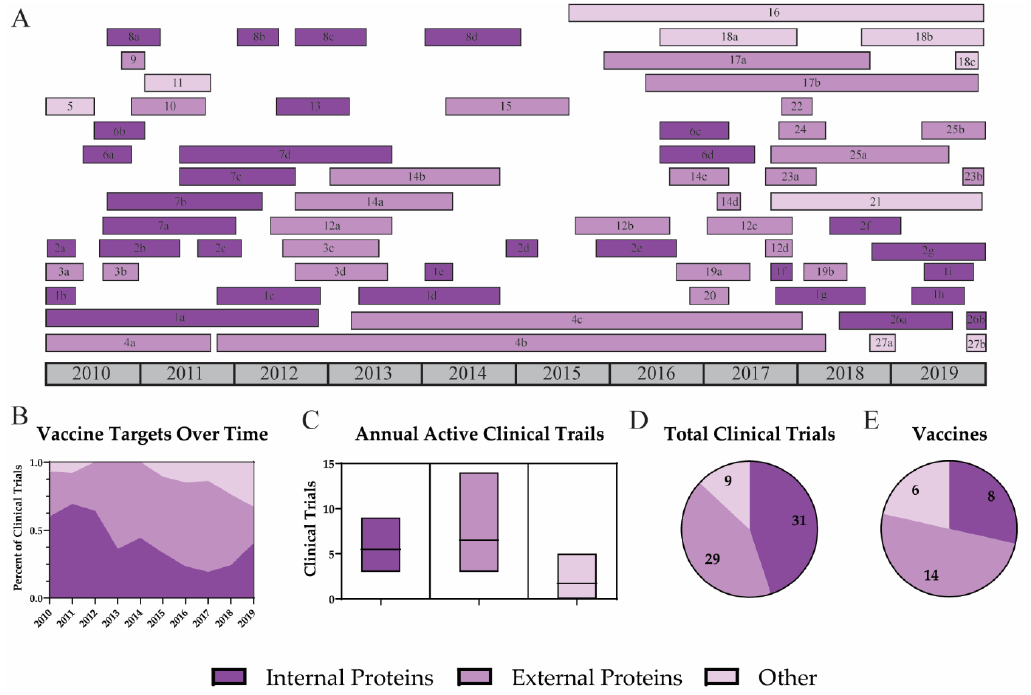
Figure 2. Targets for universal influenza vaccine strategies. A timeline of all universal influenza vaccine clinical trials is shown for vaccines which target internal proteins (dark purple), external proteins (purple), or other (light purple) antigens ( A ). Trends for vaccine targets are shown by the percent of active clinical trials each year ( B ). Average clinical trials for each target ( C ), the total number of clinical trials ( D ), and the number of vaccines directed against each target are reported ( E